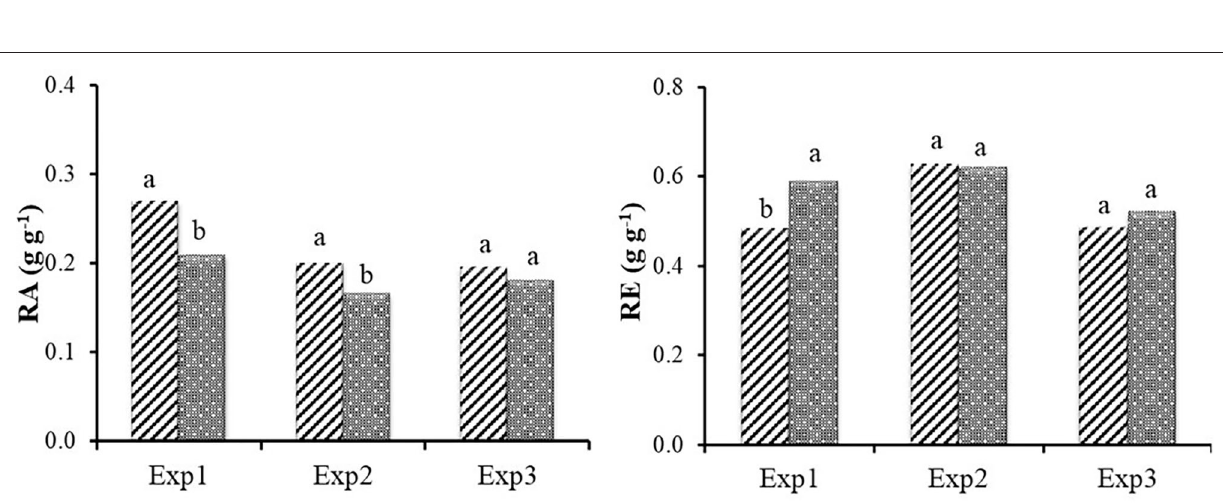
Frontiers in Agronomy |